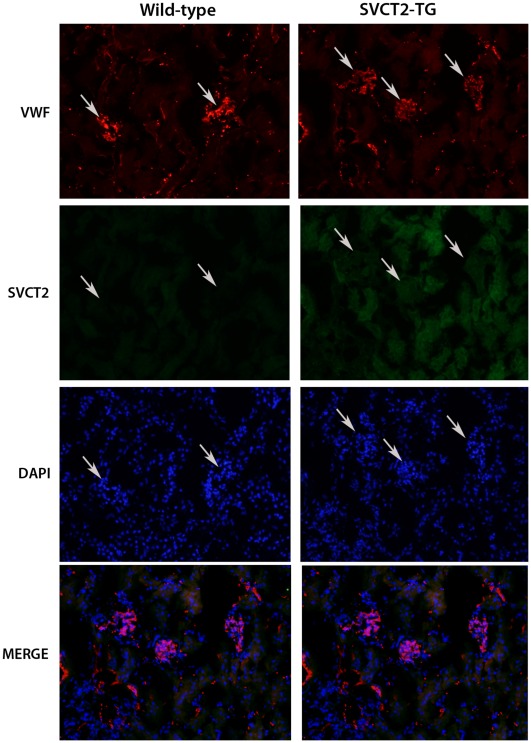
SVCT2 location in kidney.5 µm frozen kidney sections were stained for von Willebrand factor (VWF, red) and for SVCT2 (green) with non-specific stain for nuclei (blue) in wild-type (left panels) and SVCT2-Tg (right panels) kidneys. Heavier staining for VWF is observed in glomeruli (arrows) with corresponding areas of low staining for SVCT2 and high density of nuclei. A merged image (bottom panels) confirms lack of overlap of SVCT2 and VWF in glomeruli. Images taken at 20X magnification.